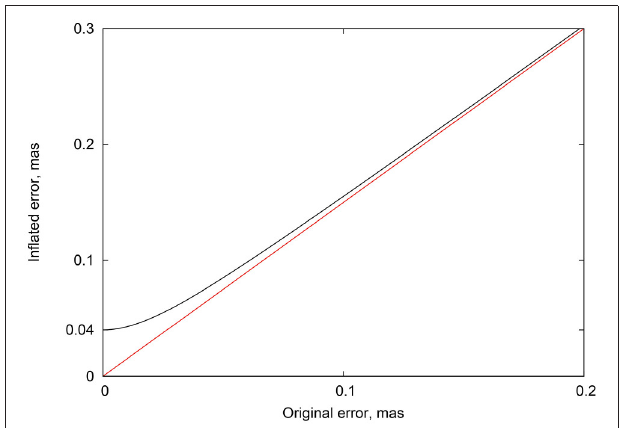
FIGURE 2 | Dependence of the inflated ICRF2 position errors on the original ones. Black line corresponds to the inflation formula σ 2 inflated = (1.5 σ computed ) 2 + (0.04 mas) 2 used in Fey et al. (2015). Red line corresponds to simple regression σ inflated = 1.5 σ computed , i.e., to the ICRF2 formula with the error floor omitted.